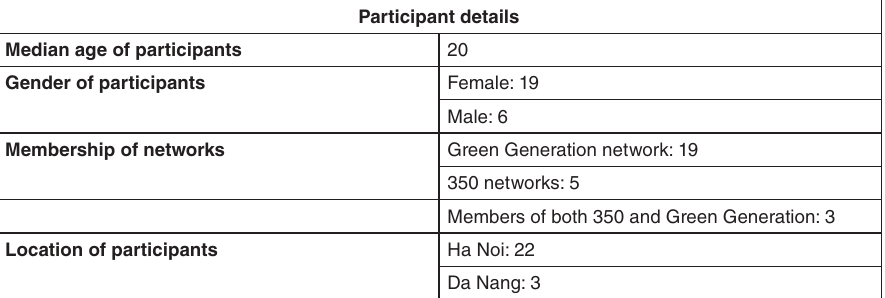
Table 1: Details of participant demographics